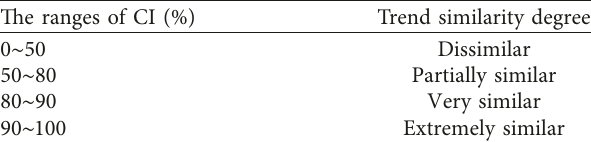
Table 1: An empirical classification of similarity by